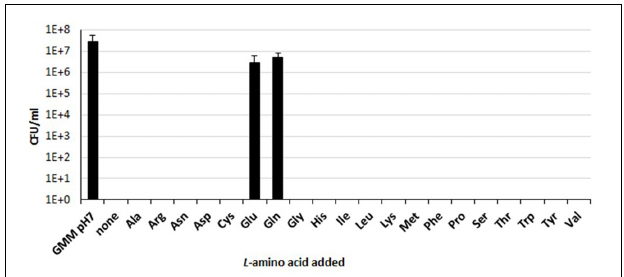
FIGURE 1 | Amino acid-dependent survival of B. microti CCM4915 after acid exposure. Bacteria from a stationary-phase culture in TS at pH 7 were harvested and incubated in modified GMM at pH 7 (first column, GMM pH 7) or at pH 2.5, either without (none) or with 3 mM of each of the indicated amino acids. Residual viability at 30 min was expressed as CFU/ml on a log10-scale. The data represent the mean (SD) of three independent experiments.